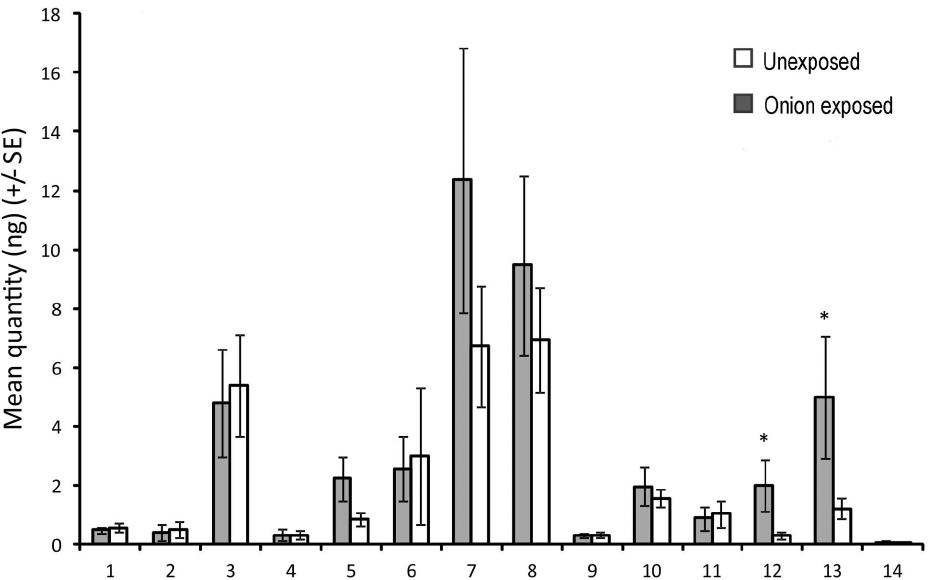
Figure 3. Volatile emissions of onion exposed and unexposed potato plants. Mean quantities ( + / 2 SE) of compounds identified from the headspace of onion-exposed and unexposed potato plants. Compound numbers: 1. ( E )-2-hexenal; 2. ( Z )-3-hexen-1-ol; 3. myrcene; 4. limonene; 5. linalool; 6. ( Z )- 4,8-dimethyl-1,3,7-nonatriene; 7. ( E )- 4,8-dimethyl-1,3,7-nonatriene; 8. a -copaene; 9. a -cedrene; 10. ( E )-caryophyllene; 11. ( E )- b - farnesene; 12. ( E )-nerolidol; 13. (3 E,7E )-4,8,12-trimethyl-1,3,7,11-tridecatetraene; 14. 6,10,14-Trimethyl-2-pentadecanone. * P # 0.05 Least Squares Means.